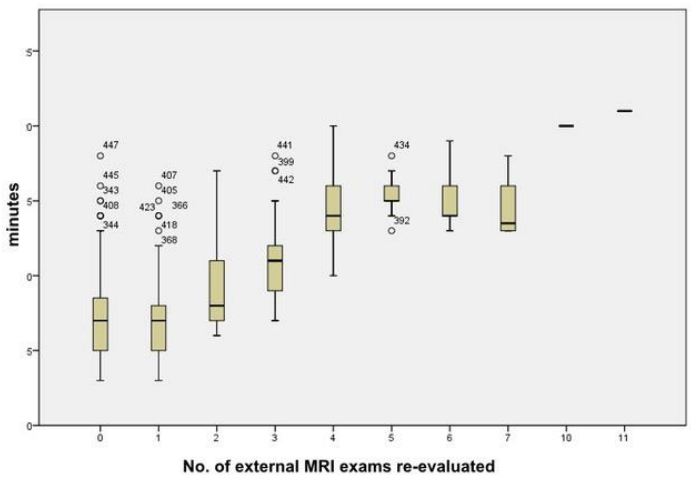
Figure 4. Box plot diagram of the time (minutes) vs. the number of external MRI exams re-evaluated.